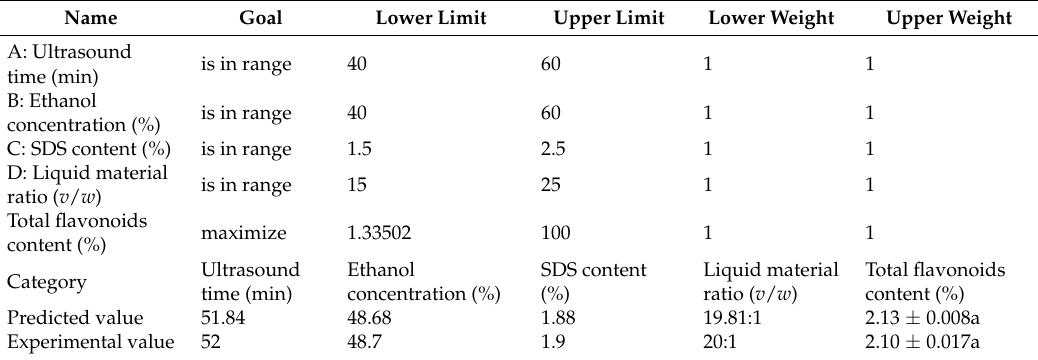
Table 3. The optimization criteria of the maximum total flavonoid content and the results of model